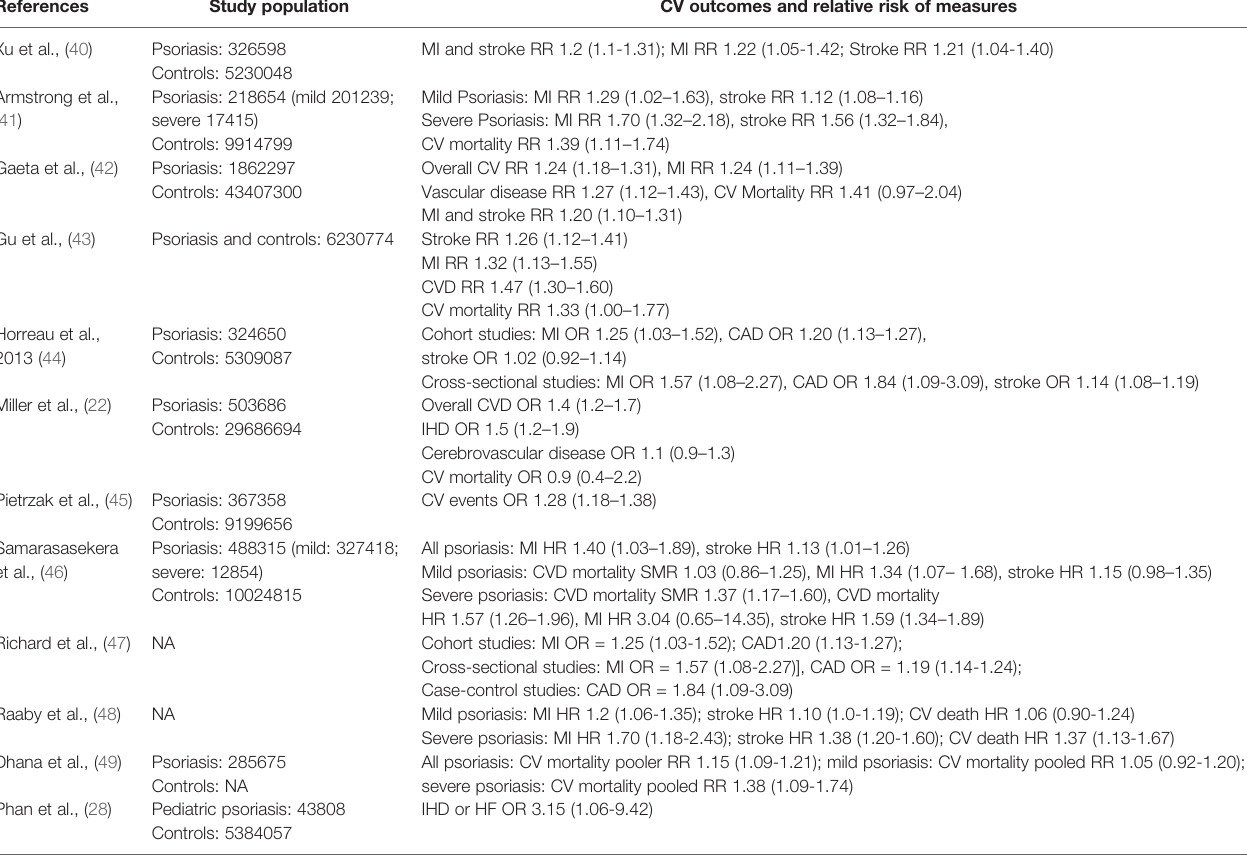
TABLE 2 | Summary of systemic reviews and meta-analysis assessing the risk of cardiovascular diseases in psoriasis.